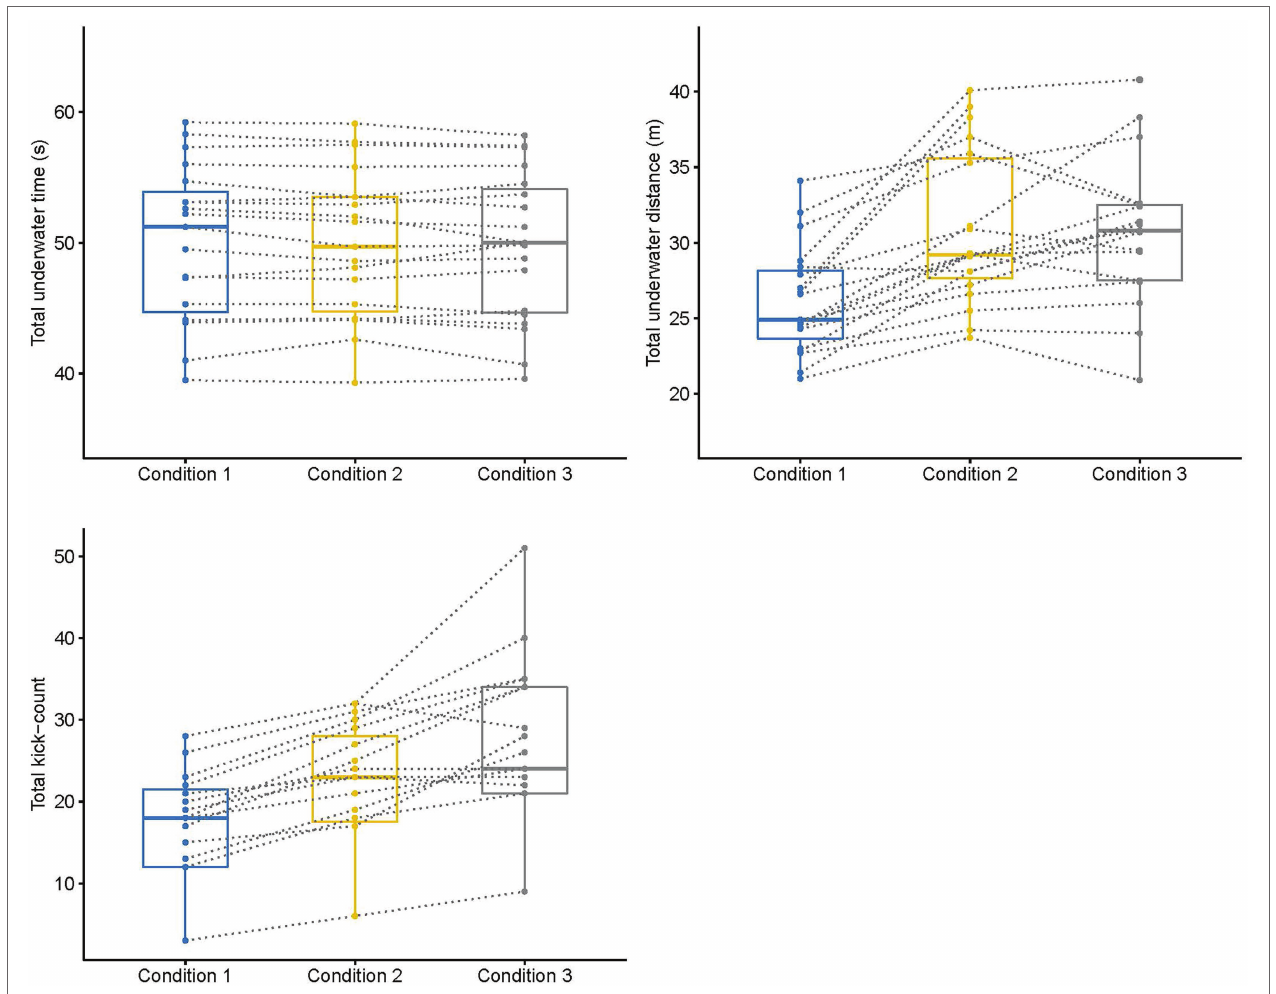
FIGURE 1 | Change of underwater parameters of competitive swimmers from free (condition 1) to constrained (conditions 2 and 3) underwater swimming conditions. Box plots indicate minimum, first quartile, median, third quartile, and maximum of the data,